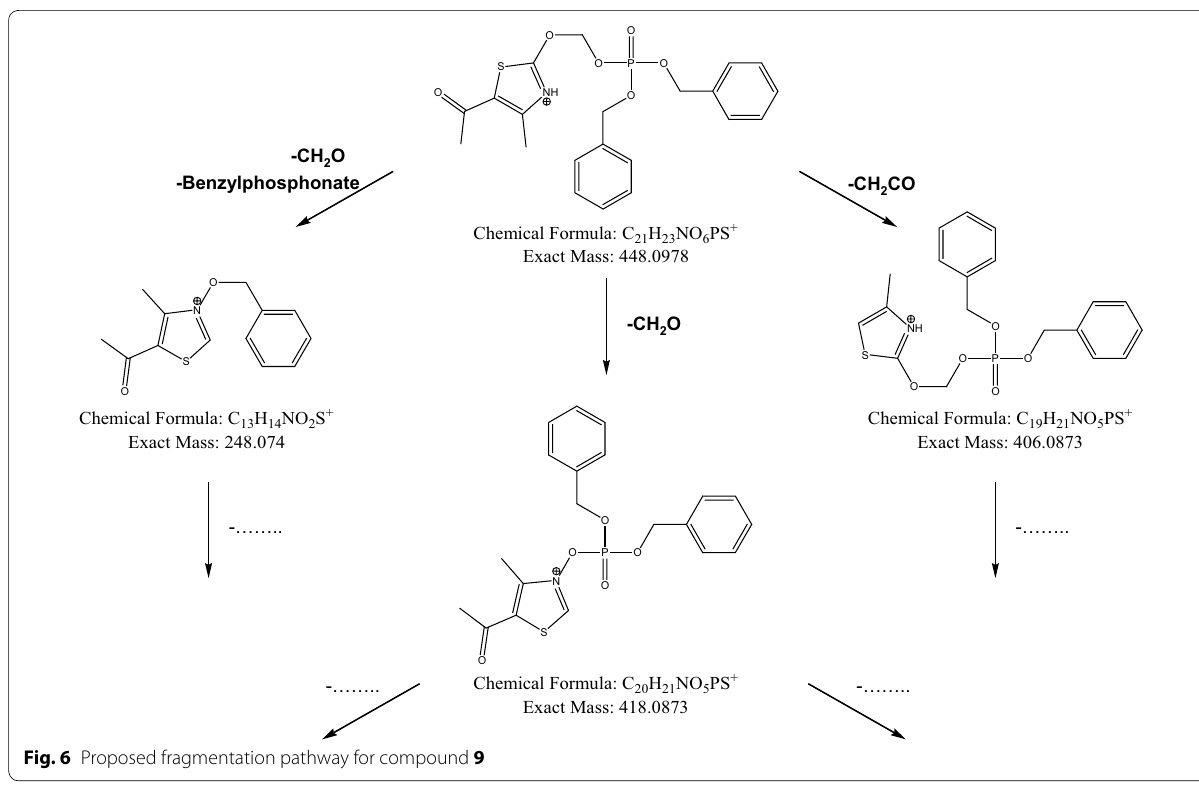
Fig. 6 Proposed fragmentation pathway for compound 9